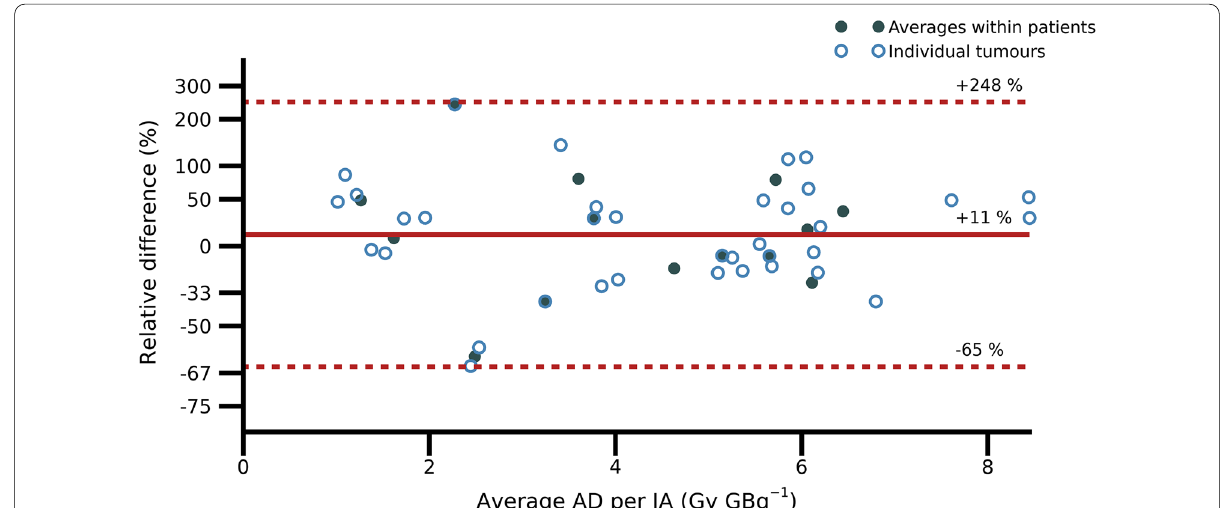
kx m , presented as k / m ) and leave-one-out interval (LOOI, min; max) = +